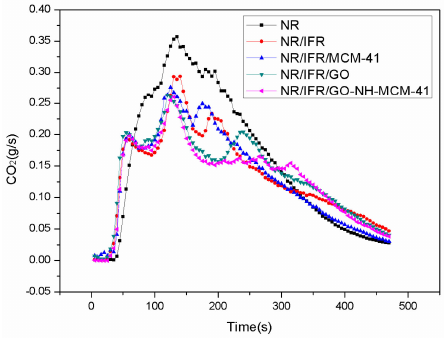
Figure 5. CO 2 curves of FRNR composites. Table 3. Cone data of FRNR